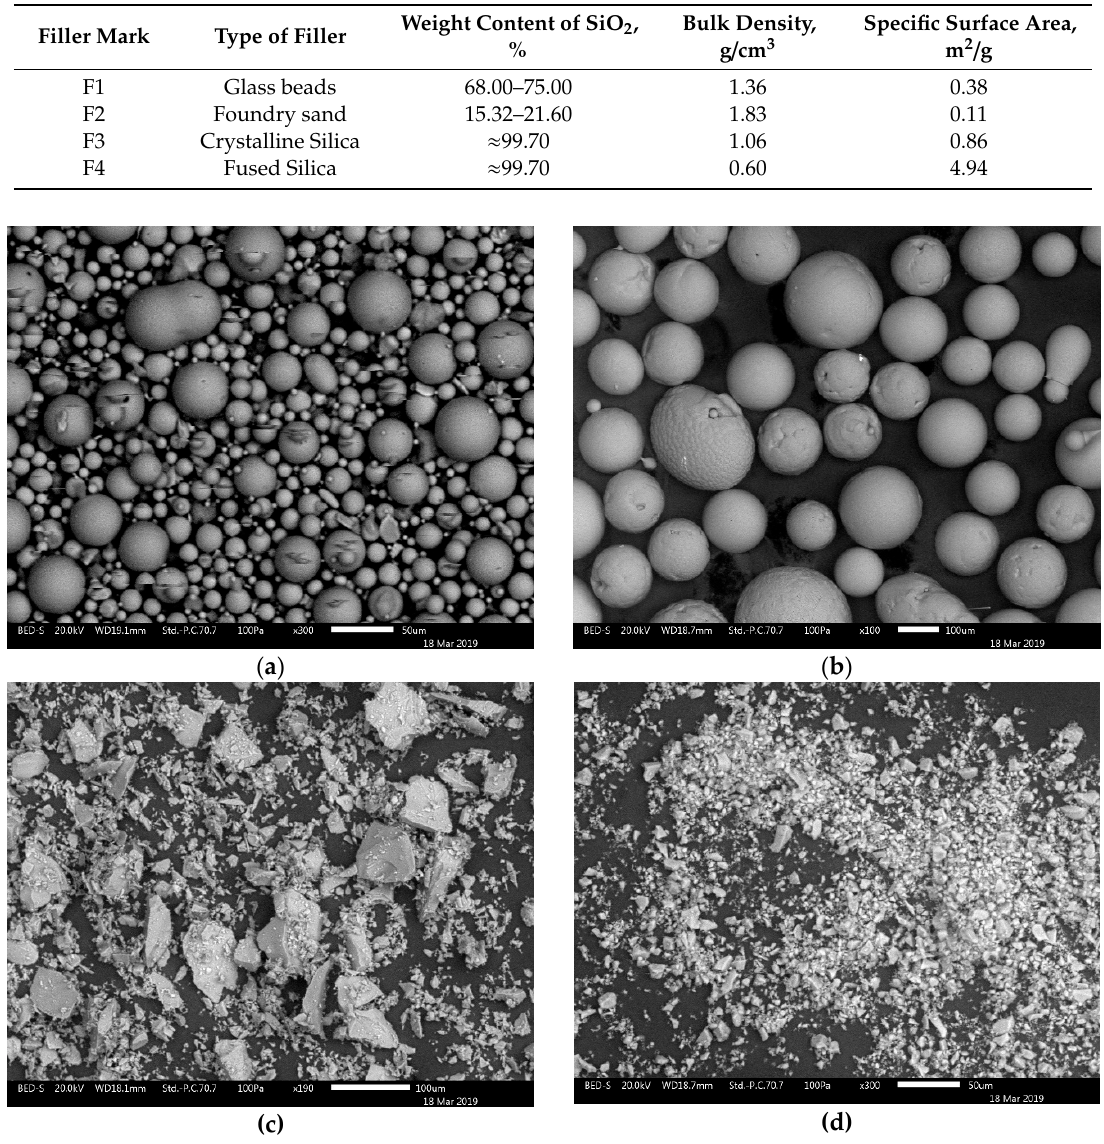
Figure 1. Scanning electron microscope (SEM) images of the tested types of fillers: ( a ) glass beads; ( b ) foundry sand; ( c ) crystalline silica; and, ( d ) fused silica.